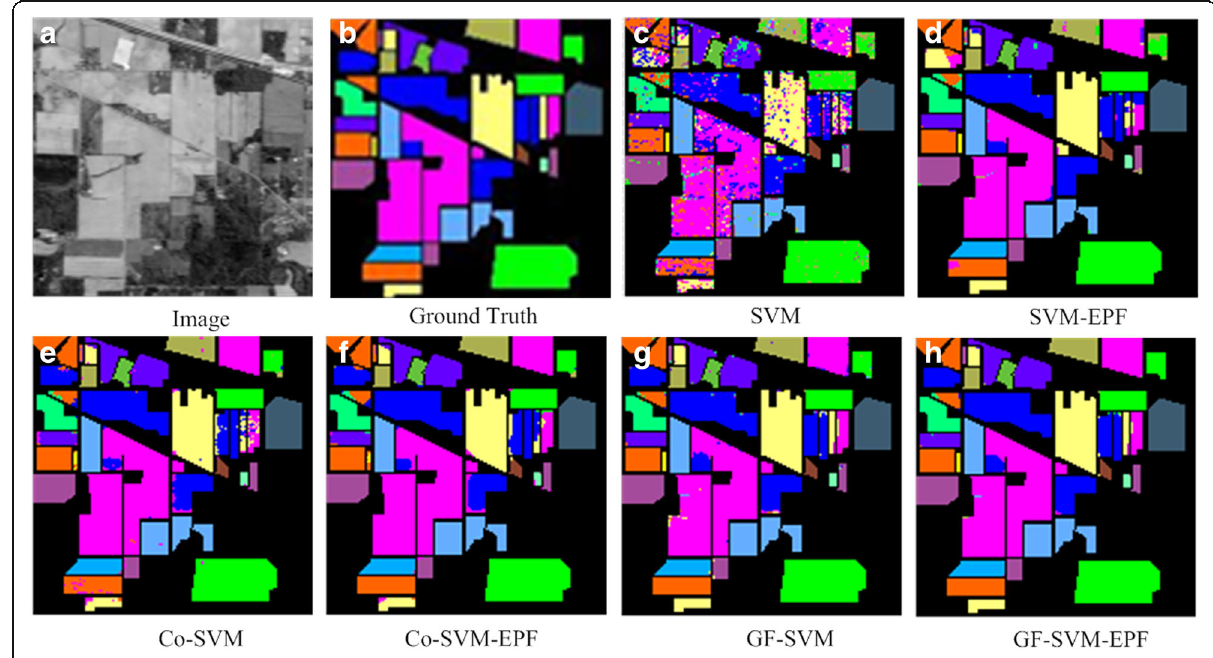
Fig. 2 Qualitative results on the Indian Pines dataset. a Image. b Ground truth. c SVM. d SVM-EPF. e Co-SVM. f Co-SVM-EPF. g GF-SVM. h